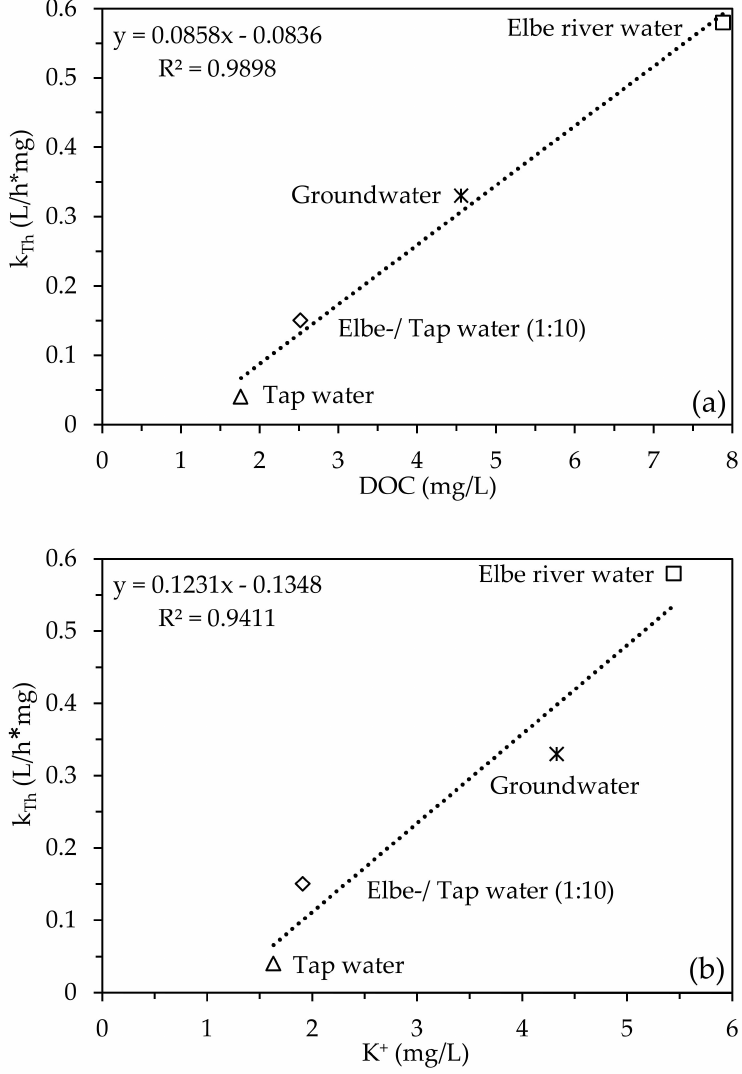
Figure 3. Correlation of Thomas model rate constant k Th with DOC ( a ) and K + ( b ) concentrations (matrix: natural; c 0 (DOC) = 1.76–7.88 mg/L; c 0 (K + ) = 1.63–5.44 mg/L; v F = 1.74 m/h; EBCT: 2.16 min; pH 0 : 7.8; T = 22 ◦ C; n =